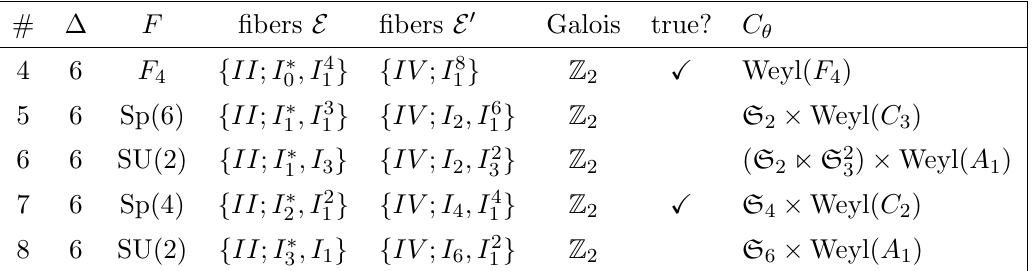
Table 7 . The (cid:12)ve symplectic coverings with covering surface E 0 which is a (cid:12)ne-tuned limit of the (cid:1) = 3 F = E 6 Minahan-Nemeshanski. In the last column C (cid:18) is the expected centralizer of the pseudo-gauged Z 2 . A X means that the false-gauging is actually a